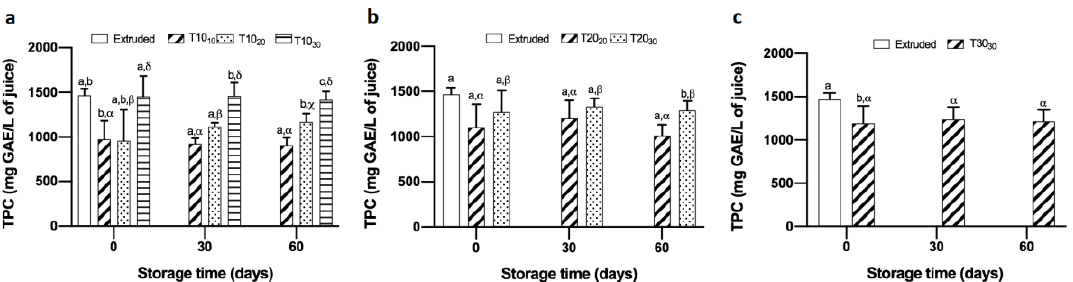
Figure 1. TPC of País grape juices at different initial extraction times determined by the Folin – Ciocalteu method, before and after 30 and 60 days of storage, where ( a ) is for juice samples collected at 10 min of the run at which sampling started (T10 10 , T10 20 , T10 30) ; ( b ) is for juice samples collected at 20 min of the run at which sampling started (T20 20 , T20 30 ) and ( c ) is for juice samples collected at 30 min of the run at which sampling started (T30 30 ). The columns with different lowercase letters for the same storage times are significantly different at p < 0.05 based on Tukey ’s test in the case of the T10 samples and Student ’s test in the case of the T20 and T30 samples. The columns with different symbols (α, β, δ, χ) for the same initial extraction time and different storage times are significantly different at p < 0.05 based on Tukey ’s test.